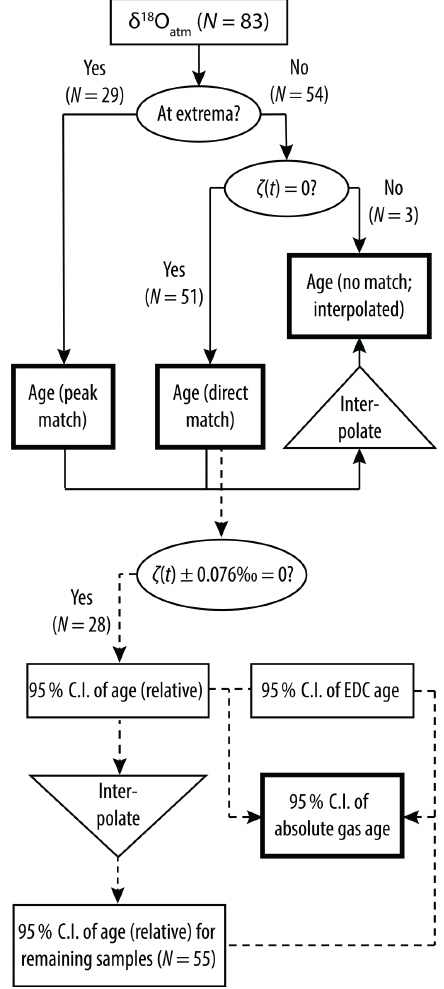
Figure 3. Schematic workflow of timescale synchronization by δ 18 O atm (solid lines) and uncertainty estimates (dashed lines). Rect- angles refer to data, circles include conditional statements, and tri- angles stand for mathematical operations. Arrows mark the work- flow. Boxes in bold lines indicate that we have arrived at the final answer. Definition of ζ ( t ) is given by Eq. (4) in the text. C.I.: confi- dence